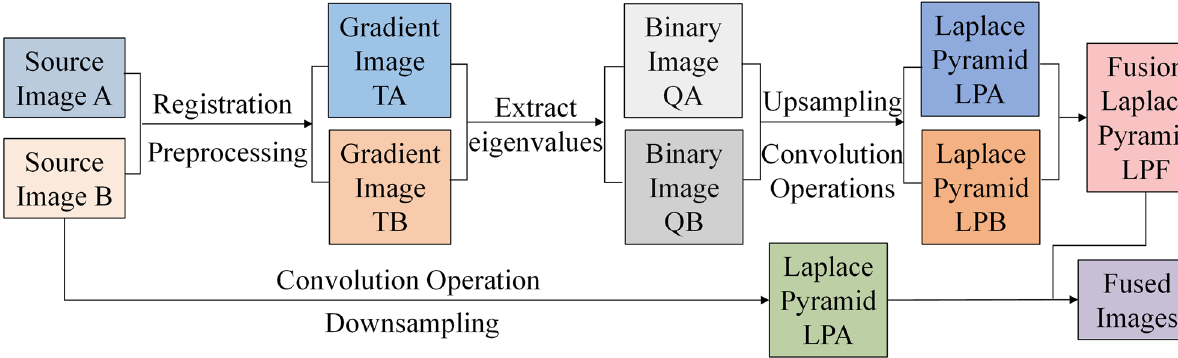
Figure 9. Multifocal image fusion algorithm.